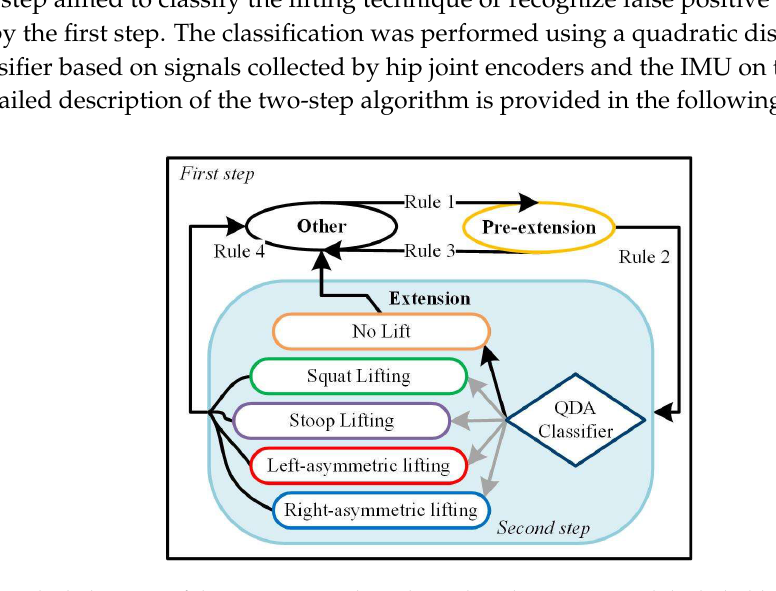
Figure 2. Block diagram of the recognition algorithm. The white region and the light blue region denote the first and the second steps of the algorithm, respectively. Rules 1–4 detect different phase transitions. Rule 1 refers to Equations (1)–(3); Rule 2 refers to Equations (4)–(6); Rule 3 refers to Equation (7), and Rule 4 refers to Equations (8) and (9).